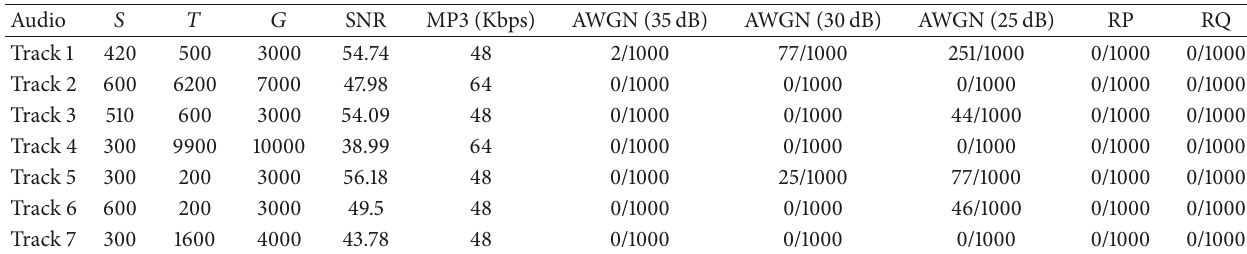
Table 1: Performance of the proposed method.